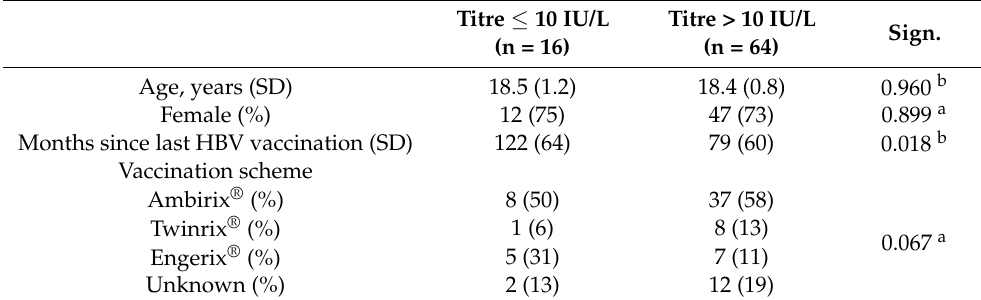
Table 1. Baseline characteristics of students who did not receive a booster although their last HBV vaccination was more than 3 months before.